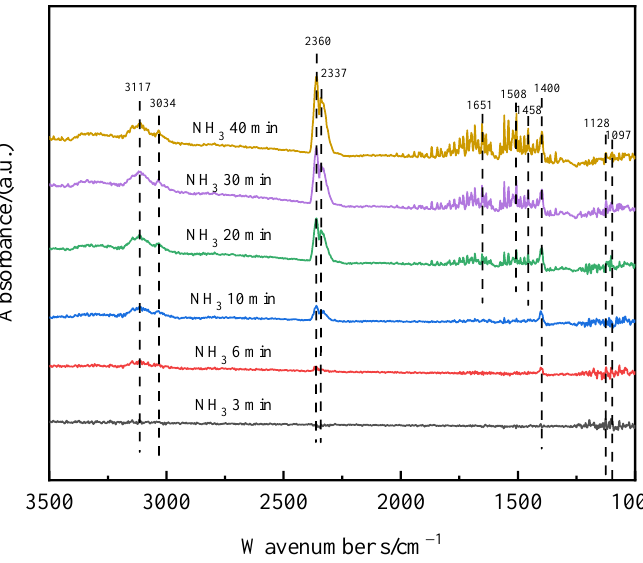
Figure 5. In situ DRIFTS of NH 3 adsorbed on the 4Cu-4Ce-4Zr/SAPO-34